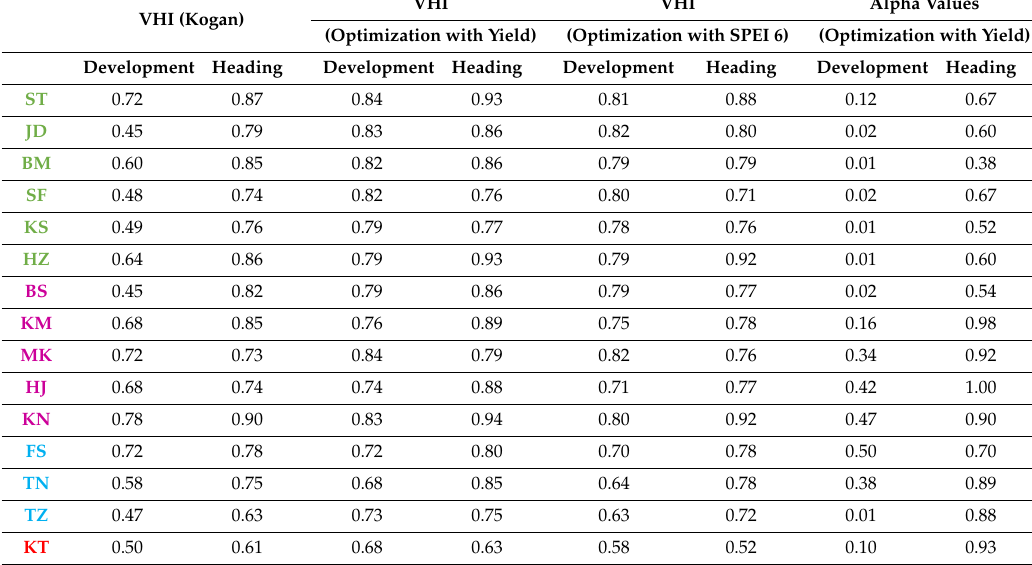
Table 8. Correlation between the VHI proposed by Kogan and the VHI with optimization with yield and the SPEI6 and yield. The value of α was optimized at the key phenological stage for all provinces. All correlation coe ffi cients are significant at the 99% level. Colors correspond to the four groups of agricultural provinces (see